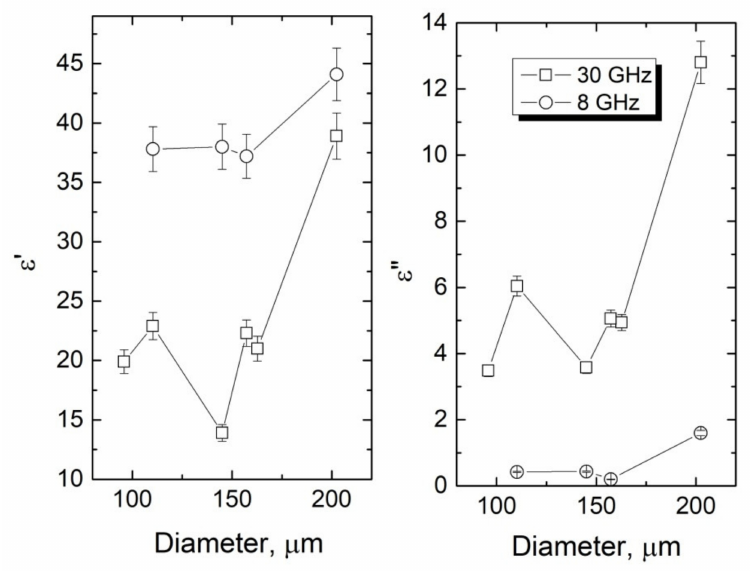
Figure 7. Complex dielectric permittivity versus coPA_A + 7 wt% MWCNTs fibers